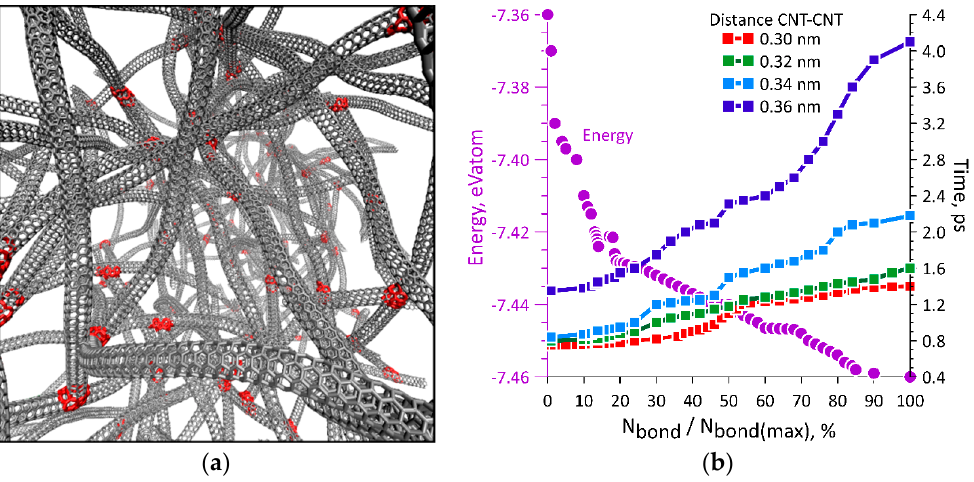
Figure 3. Formation of a carbon network: ( a ) A branched network of SWCNTs (4,4) with red regions corresponding to the nanowelding points; ( b ) plots of change in the energy of the network of SWCNTs (purple curve) and time of the formation of covalent bonds.